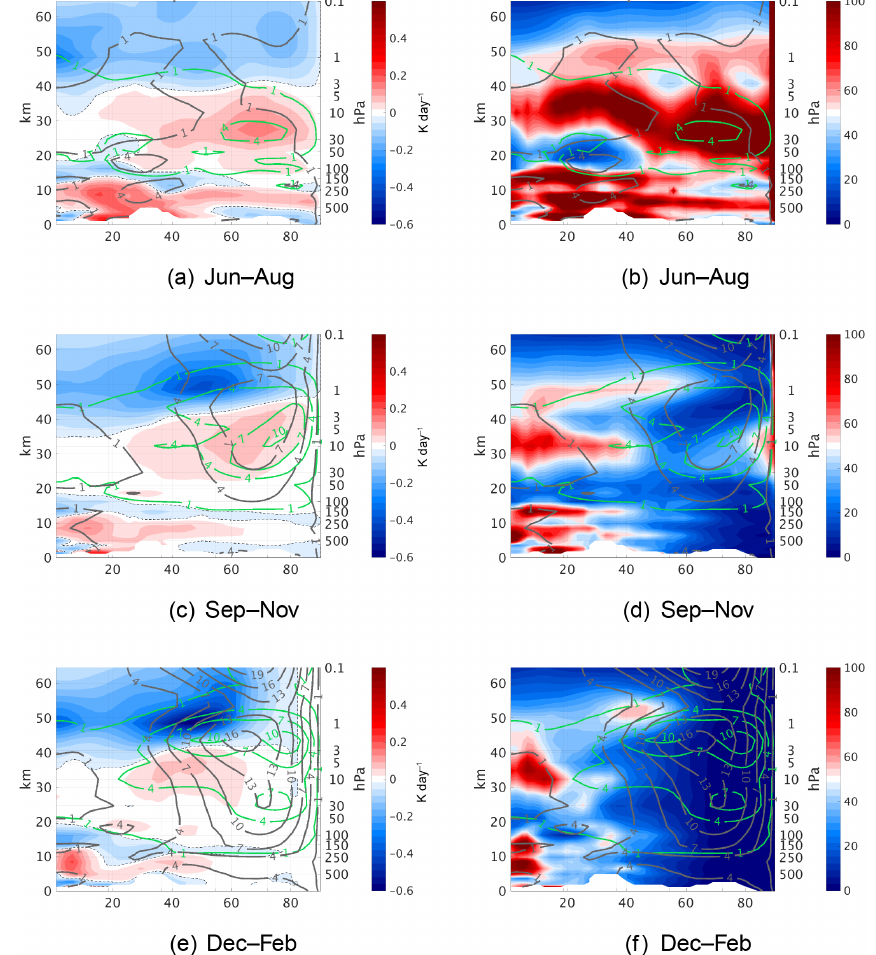
Figure 1. Monthly mean temperature tendency from shortwave radiation of temperature zonal wave 1 amplitude (a, c, e) , % SWR of the tendency from shortwave radiation (SWR) of temperature zonal wave 1 amplitude compared to longwave radiation (LWR) (b, d, f) , in the Northern Hemisphere during June–August (a, b) , October–November (c, d) , and December–February (e, f) . Temperature (ozone) wave 1 amplitudes in K (10 − 7 kgkg − 1 ) are shown in gray (green)